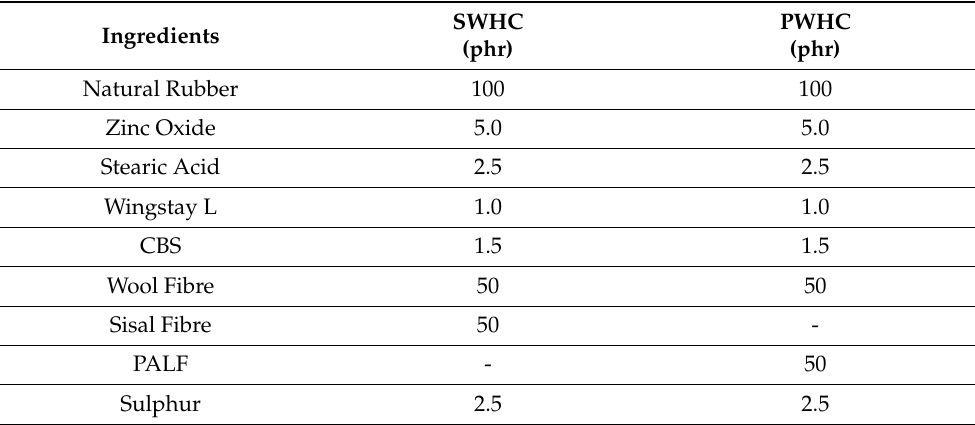
Table 1. List of rubber compounding ingredients [19,20].